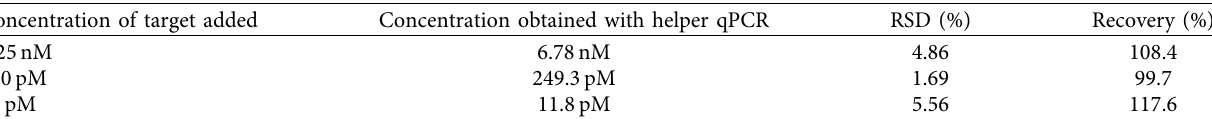
Table 3: Determination of miR-152 in human